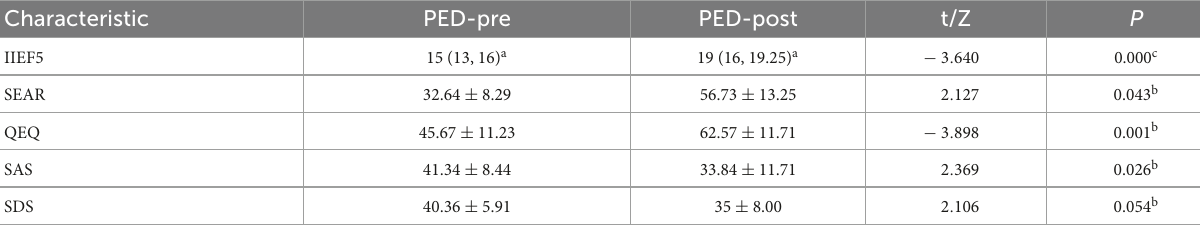
TABLE 2 Clinical outcomes of pre- and post-electroacupuncture in PED